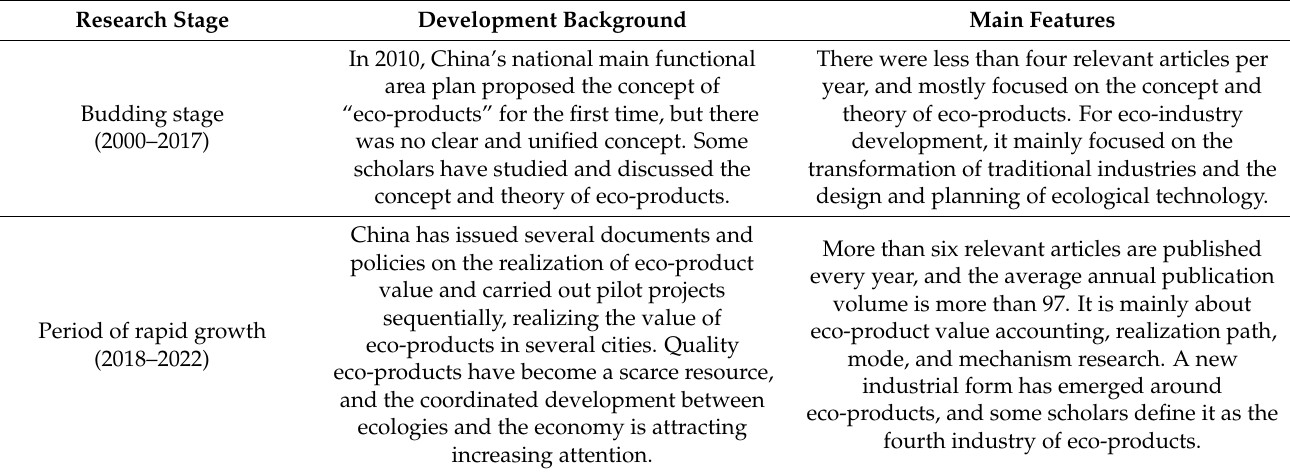
Table 1. Division of the research stages.